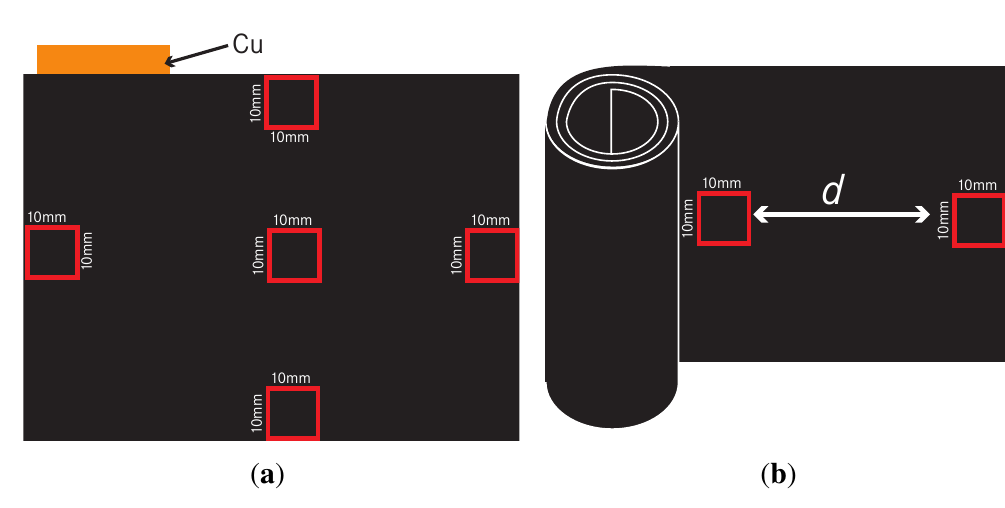
( 10 mm × 10 mm ) samples were sliced from equidistant intervals d of the jellyroll; see Figure 1(b). Figure 1. Anode sample selection from different types of cells. ( a ) Pouch cell; ( b ) cylindrical